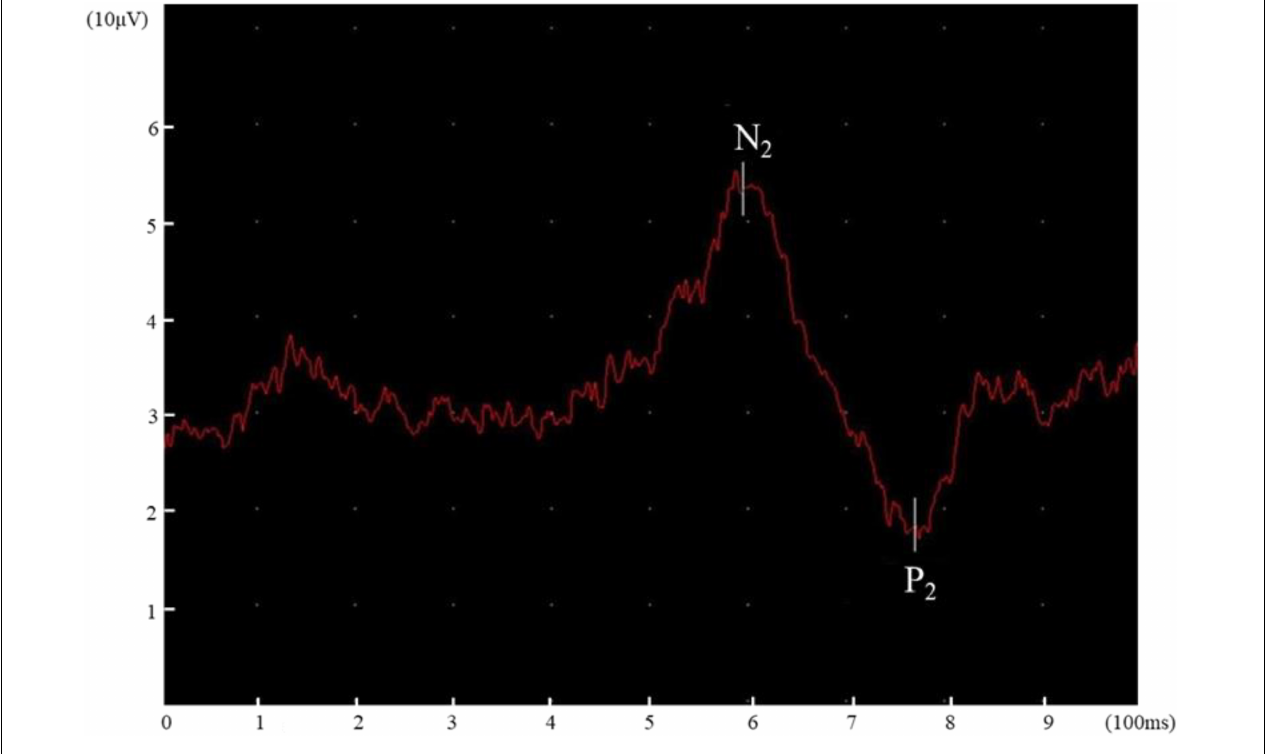
N 2 and P 2 latency are related to height, the data were presented as “N 2 latency/height” and “P 2 latency/height” (Lagerburg et al., 2015). The average height of the participants was 168.2 ± 9.4 cm (range, 156–185